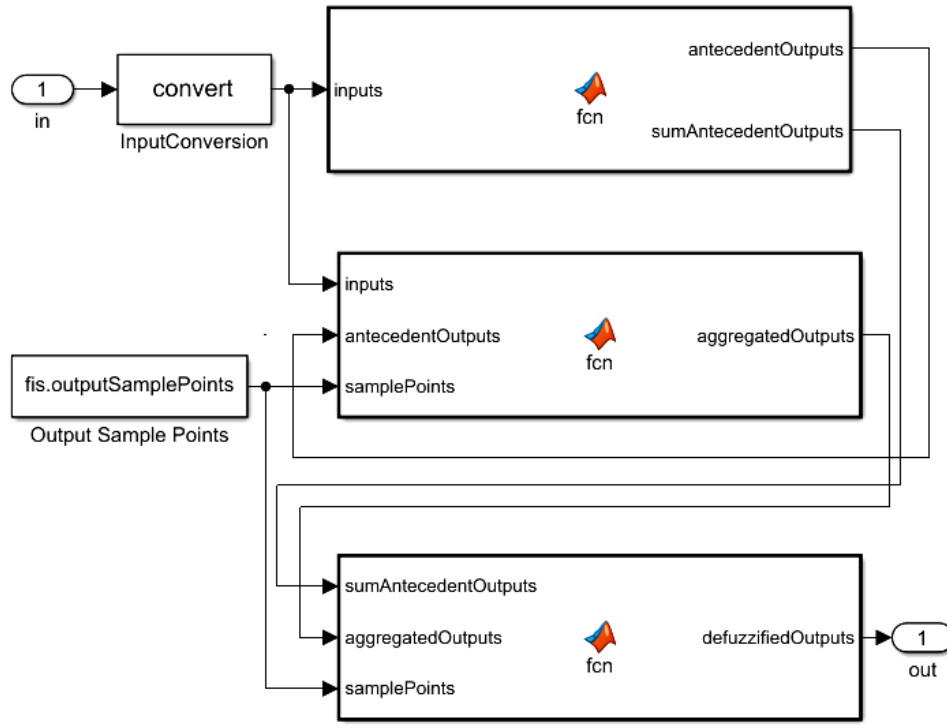
Figure 3. Simulink model flow chart of Mamdani fuzzy logic